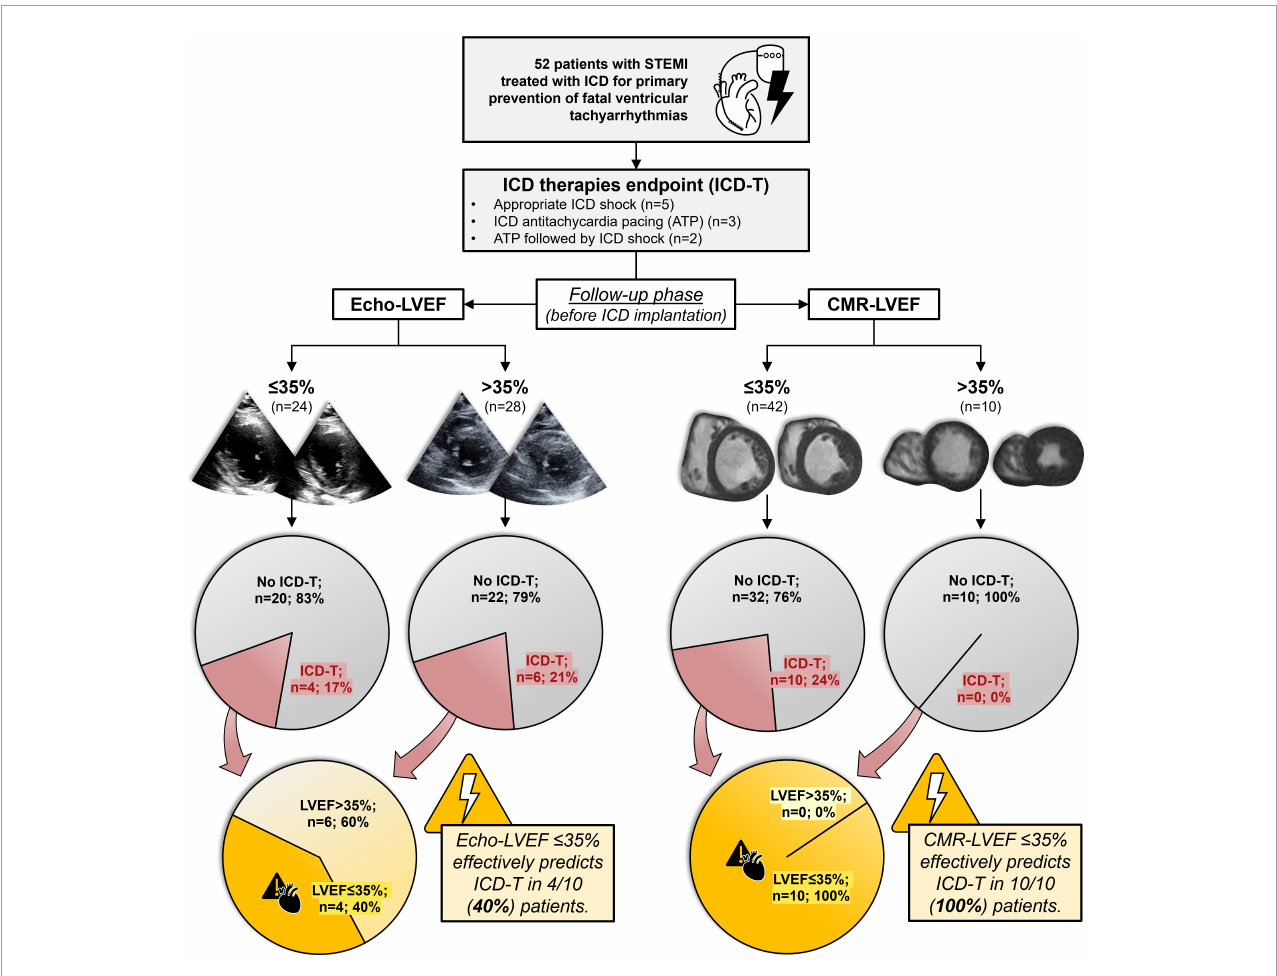
FIGURE1 Stratification of ICD-T according to Echo and CMR LVEF categories before ICD implantation. Occurrence of life-threatening ventricular tachyarrhythmias (manifesting as appropriate ICD therapies) was analyzed in a population of STEMI patients treated with ICD for primary prevention. Patients were categorized by pre-ICD LVEF ( ≤ 35% vs. > 35%) via Echo or CMR. Compared to Echo-LVEF, CMR-LVEF categories allowed for detection of 100% of ICD-T (when CMR-LVEF was ≤ 35%) and exclusion of ICD-T (when CMR-LVEF was > 35%). ATP, antitachycardia pacing; CMR, cardiac magnetic resonance; Echo, echocardiography; ICD, implantable cardioverter-defibrillator; ICD-T, appropriate implantable cardioverter-defibrillator therapies; LVEF, left ventricular ejection fraction; STEMI, ST-segment elevation acute myocardial